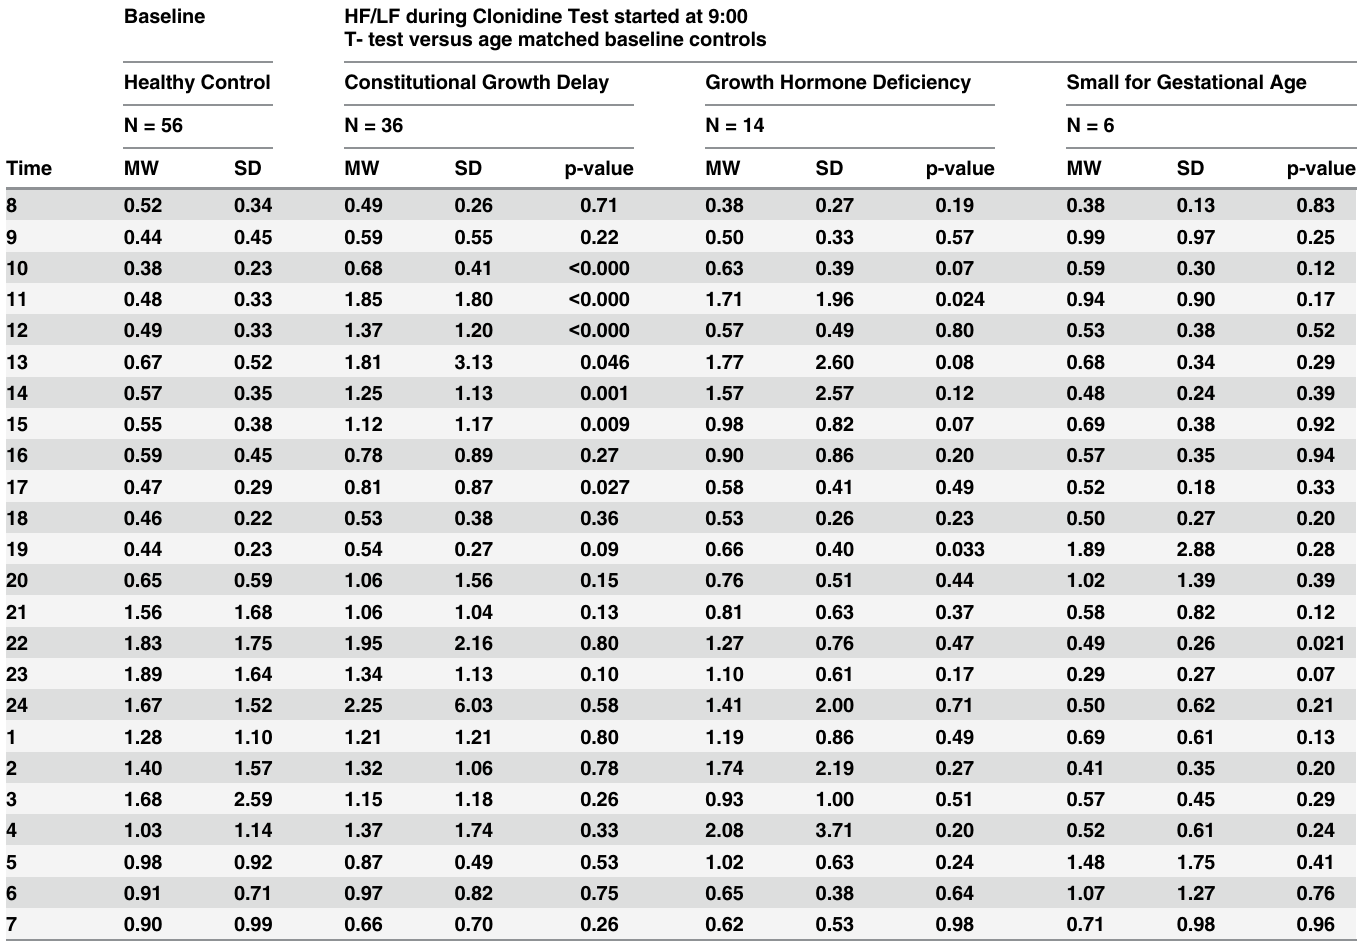
Table 4. HF/LF values during clonidine testing and healthy controls.